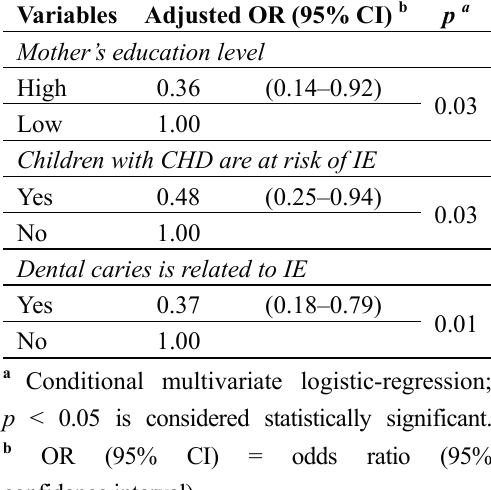
Table 3. Odds ratio for the results of the conditional multivariate logistic regression between independent variables and caries experience in children with